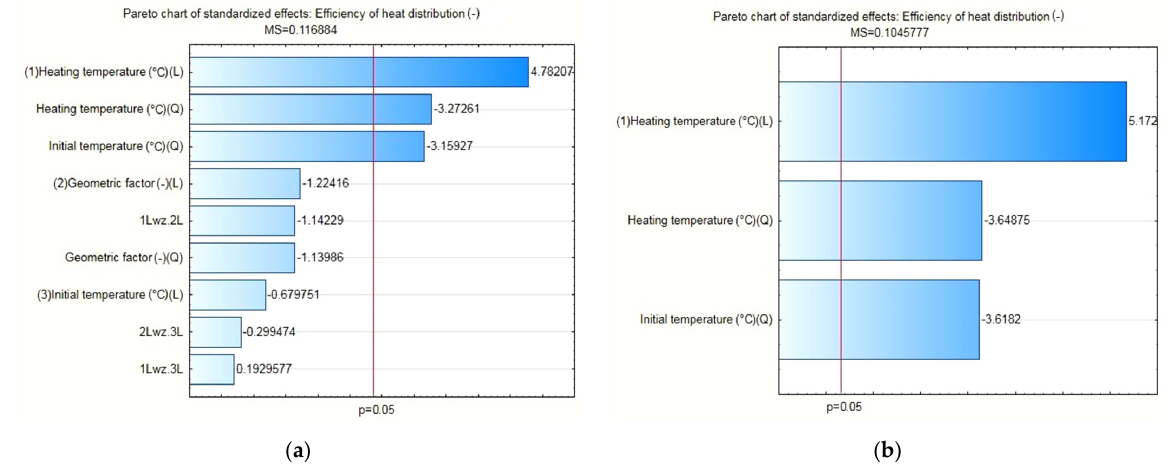
Figure 16. ( a ) Pareto chart for all input quantities of interest and their correlation to the output quantity value; ( b ) Pareto chart for the statistically significant input quantities, applicable to the PCM/copper conductor heat accumulator.